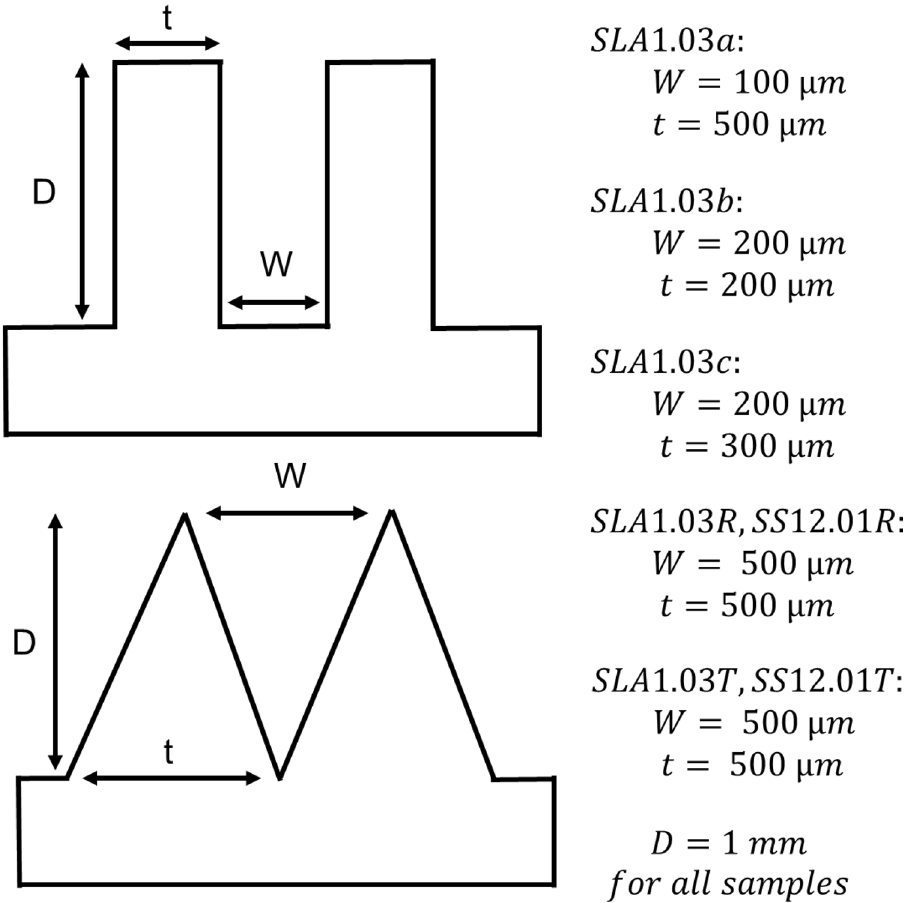
Figure 6. A schematic and dimensions of micro-grooves with various thicknesses and spacing fabricated to measure the capillary height. SLA stereolithography, SS stainless steel (DMLS), R rectangular, T